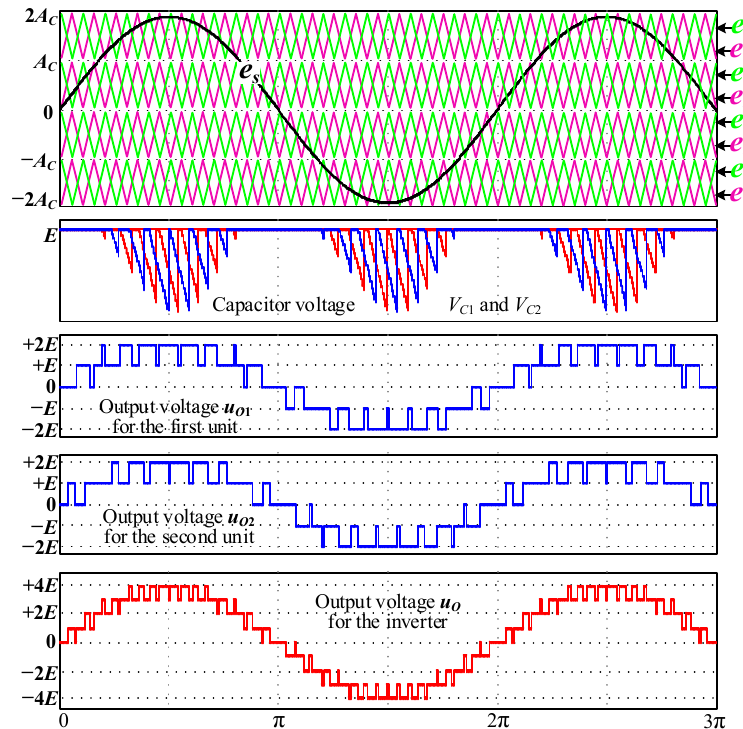
Figure 5. Modulation principle of hybrid PWM.